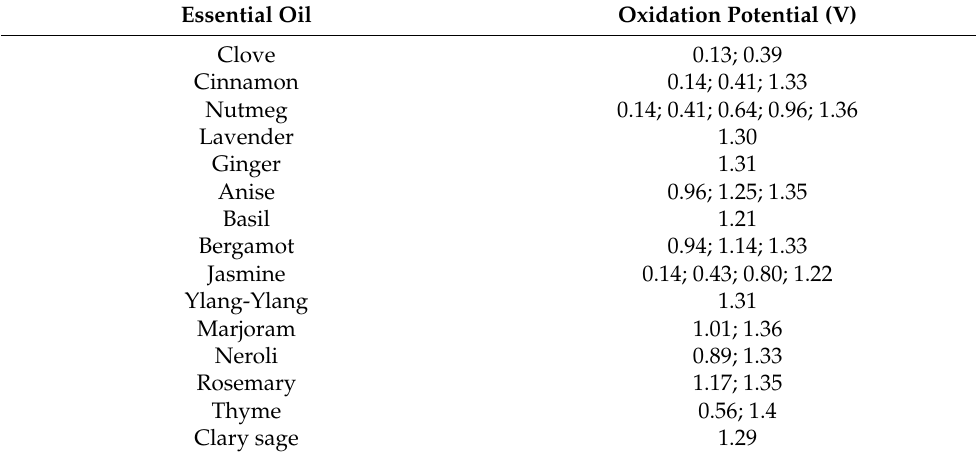
Table 1. Essential oil oxidation